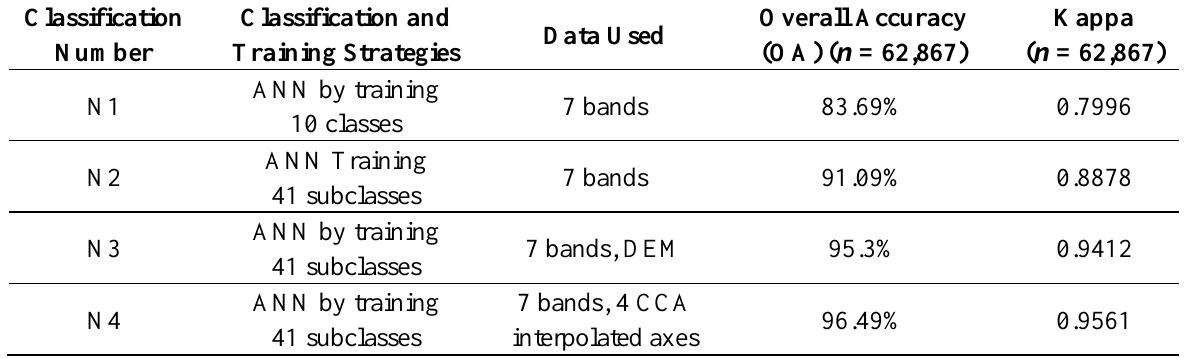
Table 10. Summary of the TM image (2 December 2003) classification results in the northern study area.